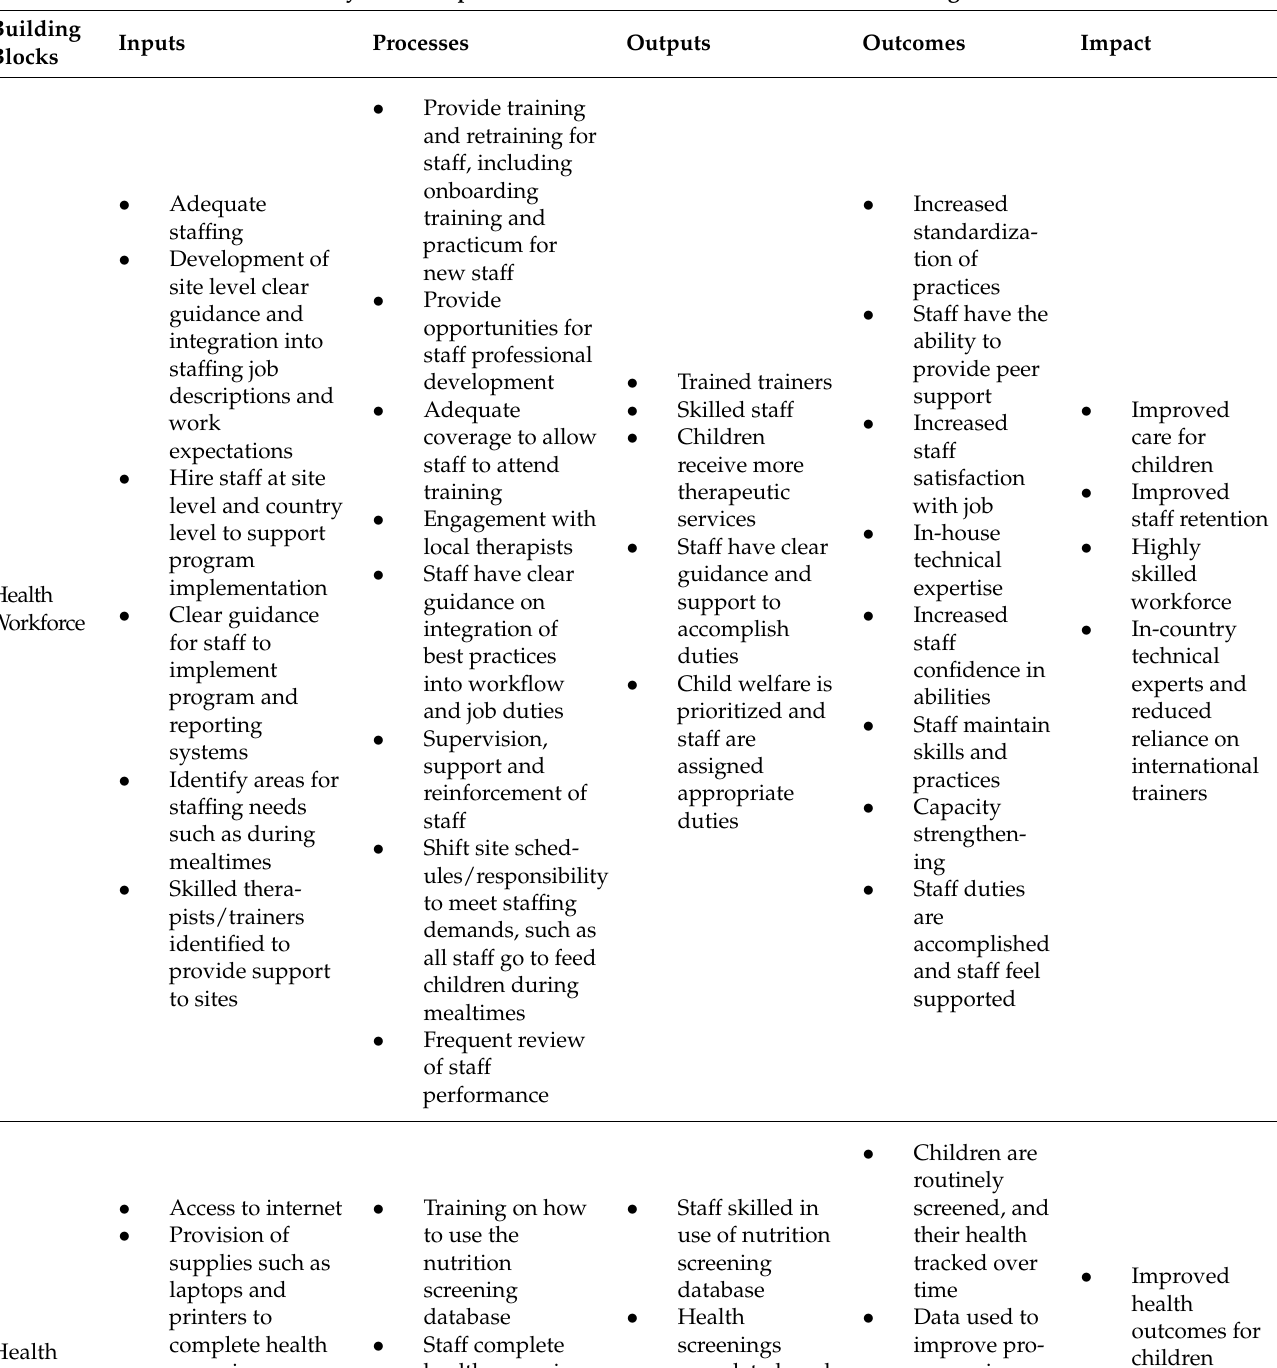
Table A3. Cont. Summary of the Implementation Process of the Child Nutrition